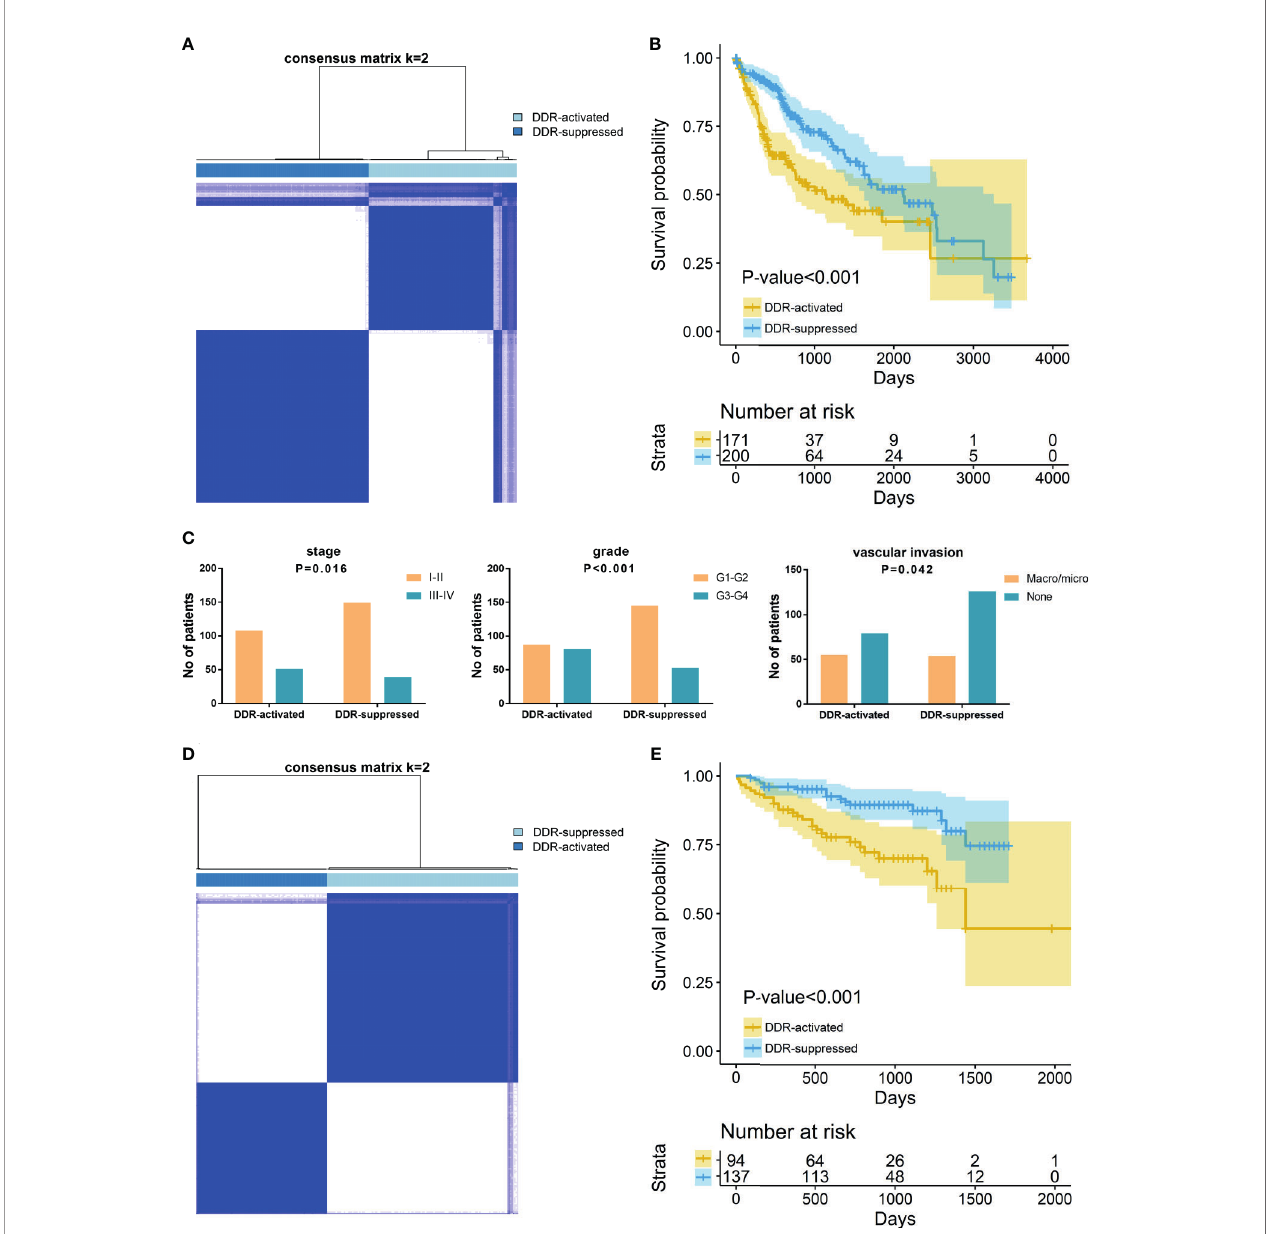
FIGURE 1 | Consensus clustering for DNA damage repair (DDR) related genes in HCC patients. (A) The consensus matrix shows patients with two distinct DDR statuses in the TCGA dataset. (B) Kaplan-Meier curves for overall survival based on DDR subgroups (Log-rank test) in TCGA dataset; (C) Tumor stage, grade, and vascular invasion distribution differences between DDR subgroups; (D) The consensus matrix shows patients with two distinct DDR statuses in the ICGC dataset; (E) Kaplan-Meier curves for overall survival based on DDR subgroups (Log-rank test) in ICGC